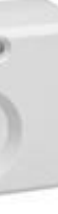
Figure 4. Pyro Thermal Sensor by FLIR.